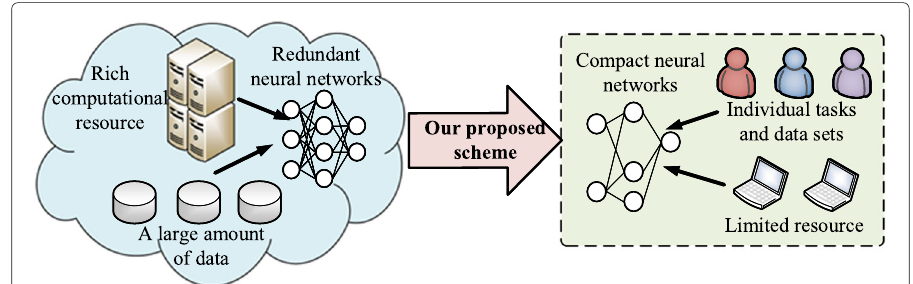
Fig. 4 A high level view of how our proposed scheme functions in converting a large neural network at cloud level to a lightweight neural network in edge